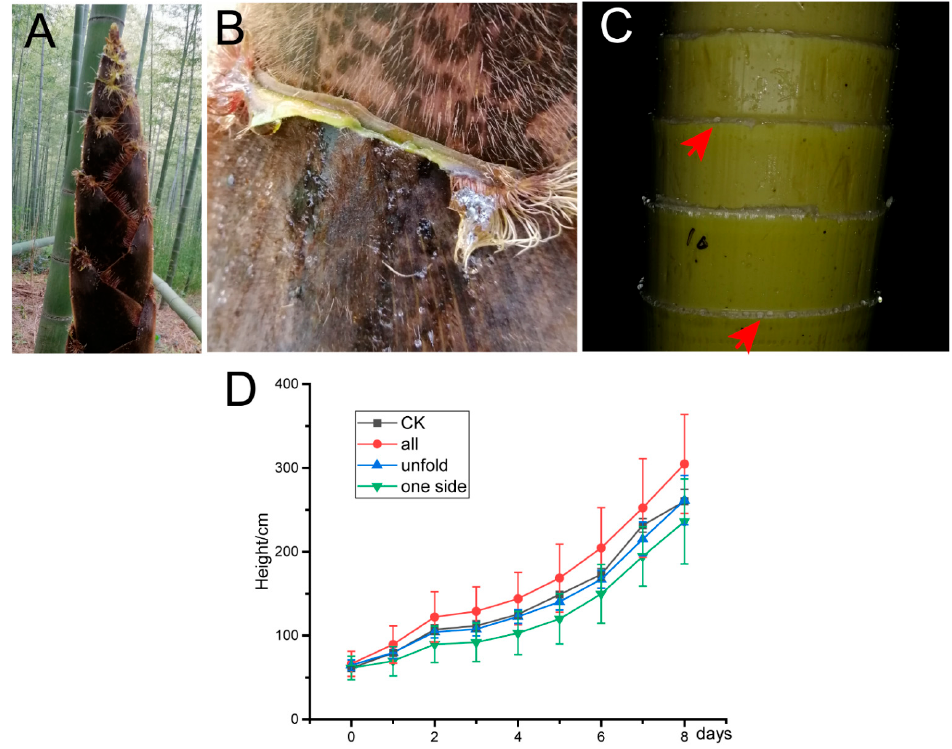
Figure 6. ( A ) All sheath blades removed from the bamboo shoot. ( B ) Guttation after removal of the sheath blades; ( C ) guttation after removal of the bamboo sheaths; the red arrow points to where the guttation liquid is emerging. ( D ) Changes in the height of bamboo shoots over eight days after culling the sheath. n = 3. The data were the mean height of the three plants. “CK” represents unprocessed bamboo shoots, “all” represents shoots with all culm sheaths removed, “unfold” represents only culm sheaths expanded, and “one side” represents shoots with only one culm sheaths removed.